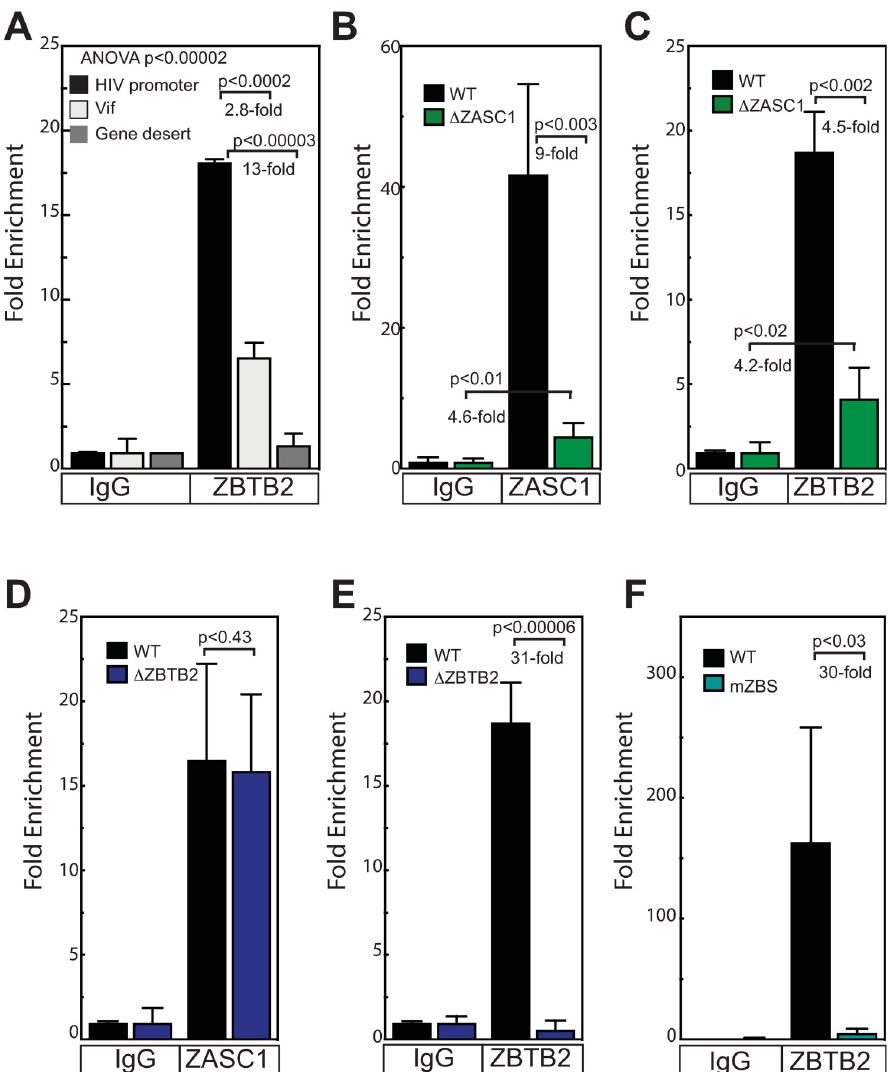
Fig 8. ZASC1 regulates recruitment of ZBTB2 to the HIV-1 promoter. (A) ChIP results from Jurkat cells transduced with NL43E-R-Luc using an antibody against ZBTB2 or non-specific IgG control antibody and primer sets targeting the HIV-1 promoter (-54 to +32) and downstream sequences in the Vif gene (+4,599 to +4,619) or a region on chromosome 12 that lacks active genes (gene desert). ChIP analysis of (B) ZASC1 and (C) ZBTB2 recruitment to the HIV-1 promoter in infected WT Jurkat and Jurkat ZASC1 knockout cells. (D-E) ChIP analysis of (D) ZASC1 and (E) ZBTB2 recruitment to the HIV-1 promoter in infected WT Jurkat and Jurkat ZBTB2 knockout cells. (F) ChIP analysis of ZBTB2 recruitment to the HIV-1 promoter in WT Jurkat cells infected with an HIV-1 vector with either a WT LTR or an LTR variant with all four ZASC1 binding sites mutated. Immunoprecipitation and Real-time PCR analysis were performed and normalized to input controls as a percentage of starting material for immunoprecipitation and fold enrichment of experimental IPs relative to IgG controls reported. For each panel, the data shown are the average mean values obtained in an experiment performed with quadruplicate samples and are representative of three or more independent experiments. For (A), ANOVA analysis was performed and for P- values < 0.05 a Tukey’s HSD was performed and relevant P-values reported. For (B to F) P-values were calculated using a standard Student’s t-test and significant changes are